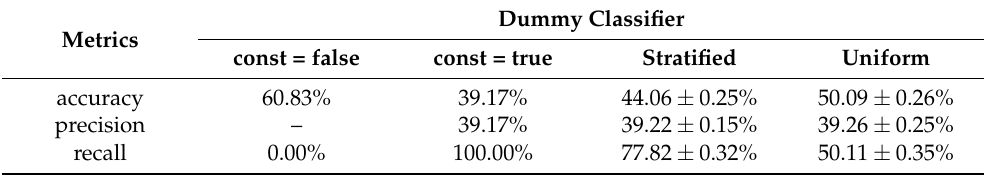
Table 8. Performance of the Scikit Dummy Classifier in a gray copy per-frame detection